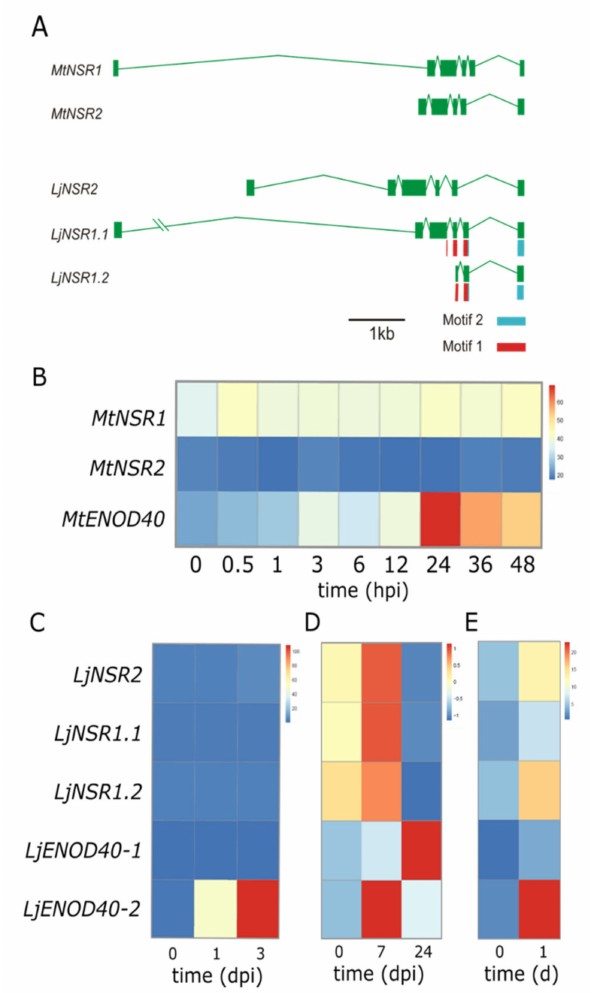
Figure 2. Gene structure and alternatively spliced variants of NSR genes and their expression profile, together with the lncRNAs ENOD40 of Medicago truncatula and Lotus japonicus during nodulation. ( A ) Exon-intron structure of NSRs genes in both species. The alternative splicing variant LjNSR2.2 includes part of exon 4 and exons 5 and 6, which coded for motif 1 (blue box) and motif 2 (orange box). ( B ) Heat map of NSRs and ENOD40 expression in inoculated roots of M. truncatula [17]. ( C ) Heat map of L. japonicus NSR1.1 , NSR1.2 , NSR2 , ENOD40-1 , and ENOD40-2 expression in root hairs post